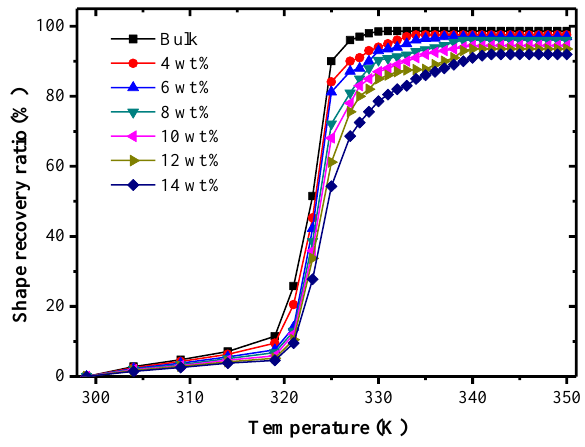
Figure 18. The shape recovery ratio of SMP composites with different chopped carbon fiber contents under different temperatures.